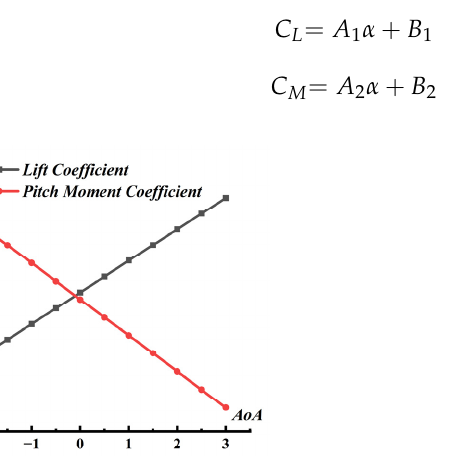
Figure 6. The lift coefficient and pitch moment coefficient curves.